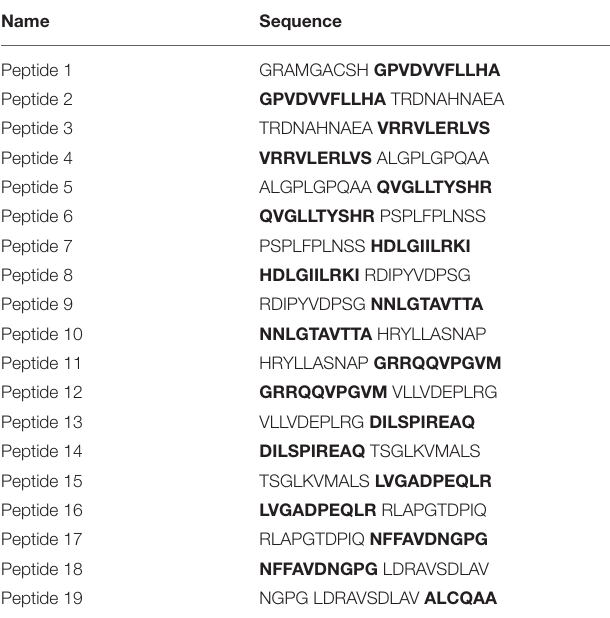
TABLE 1 | vWFA2-derived polypeptides used for epitope